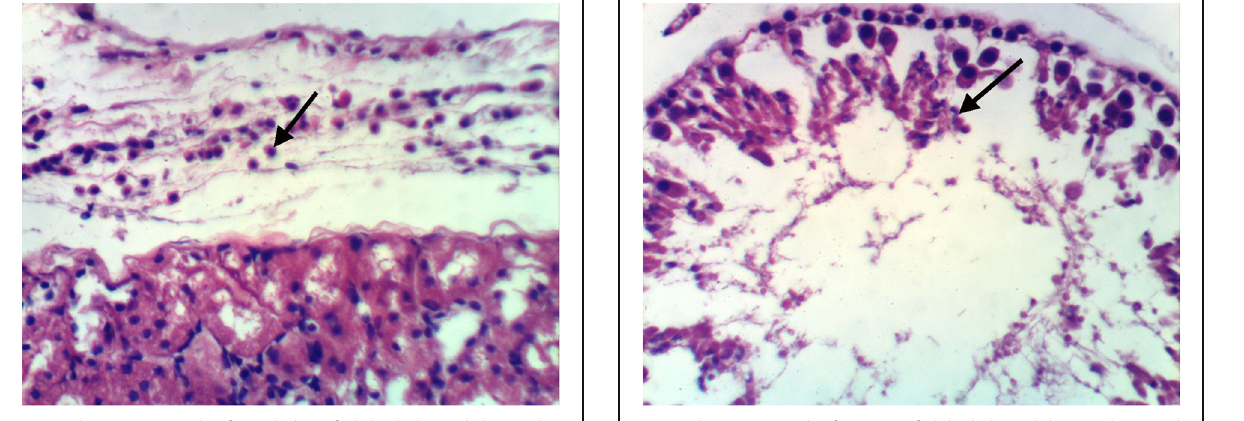
Fig. 3 Photomicrograph of rat ’ s kidney fed the balanced diet and orally administered pot.bromateshowing proteinaceous material in the Bowman ’ s space (H&E × 400)